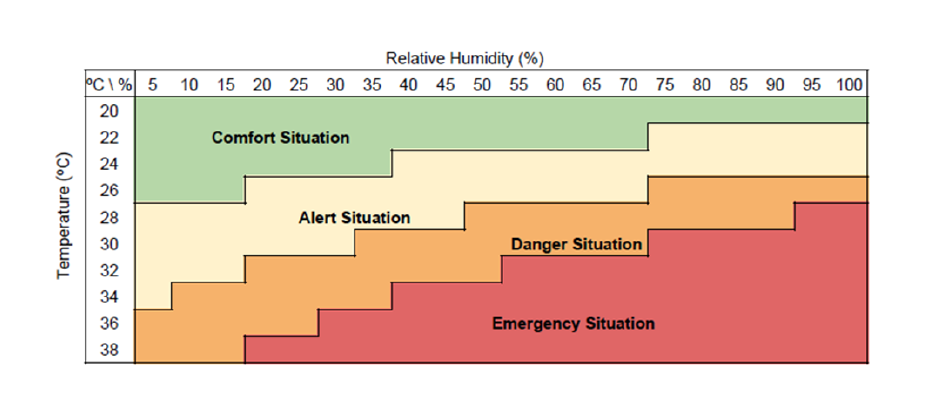
Figure 1. HIS (Heat Stress Index) for poultry